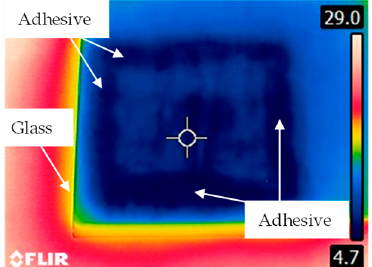
Figure 13. View of the sample with visible and indicated areas of adhesive occurrence in combination—glass side examination.